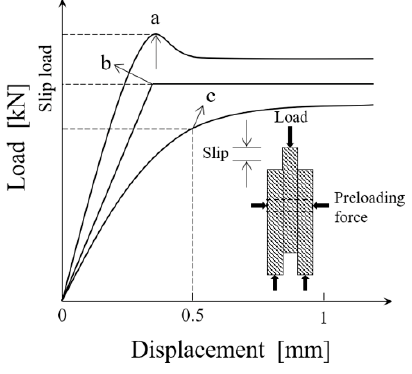
Figure 3. Three types of slip load curves [10].